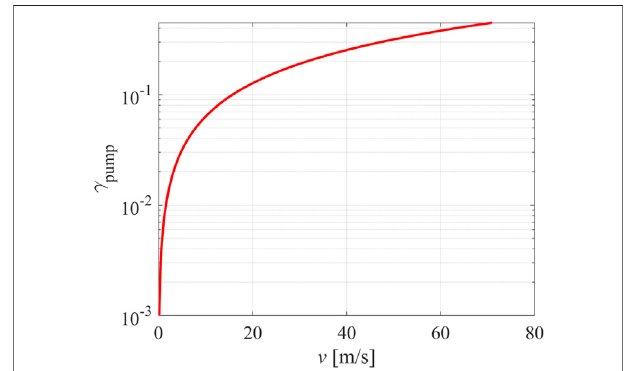
FIGURE 3 | Virtual recombination coef fi cient of the pump duct versus the drift velocity of oxygen atoms at room